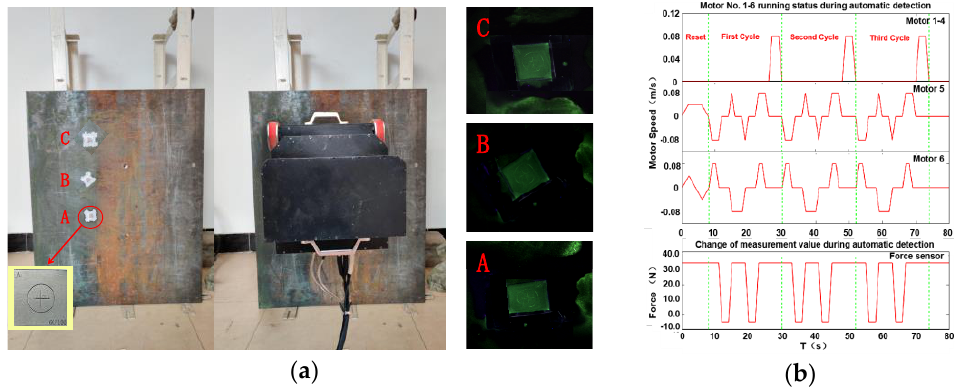
Figure 14. Continuous detection process. ( a ) Experimental platform and results; ( b ) changes of the robot motor speed and the force sensor.